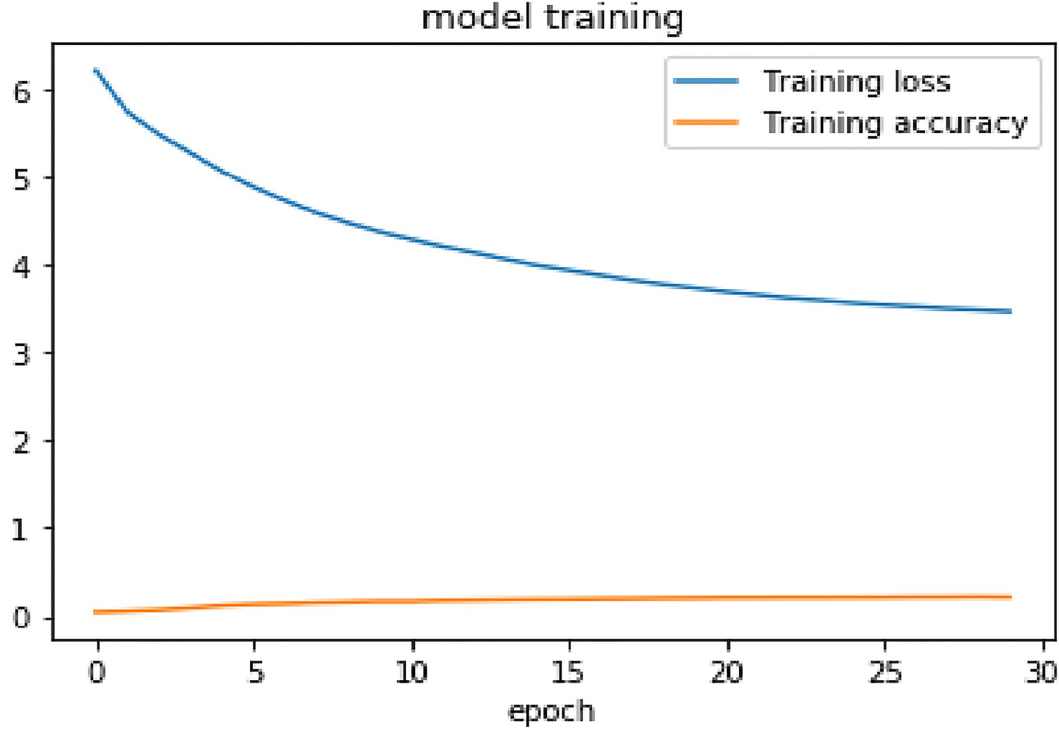
Fig 3. Training loss and training accuracy for 30 epoch.